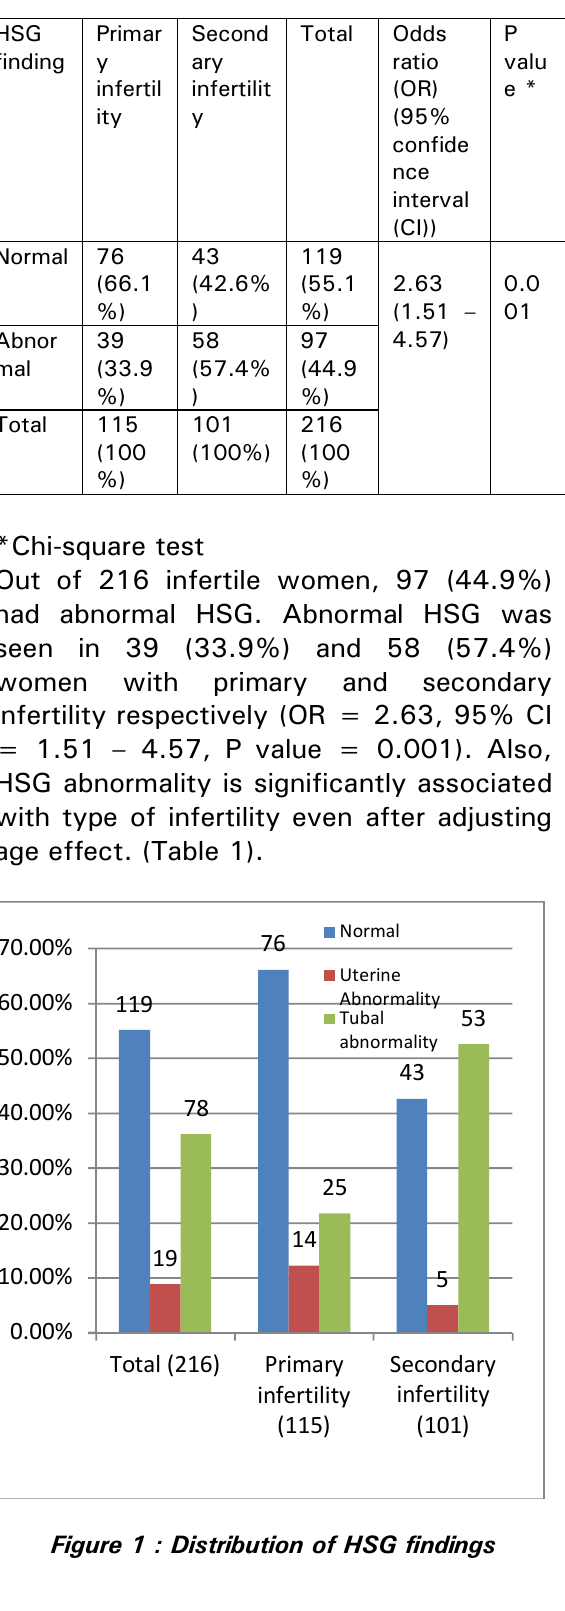
Table 2: Type of abnormality in HSG (n=97)